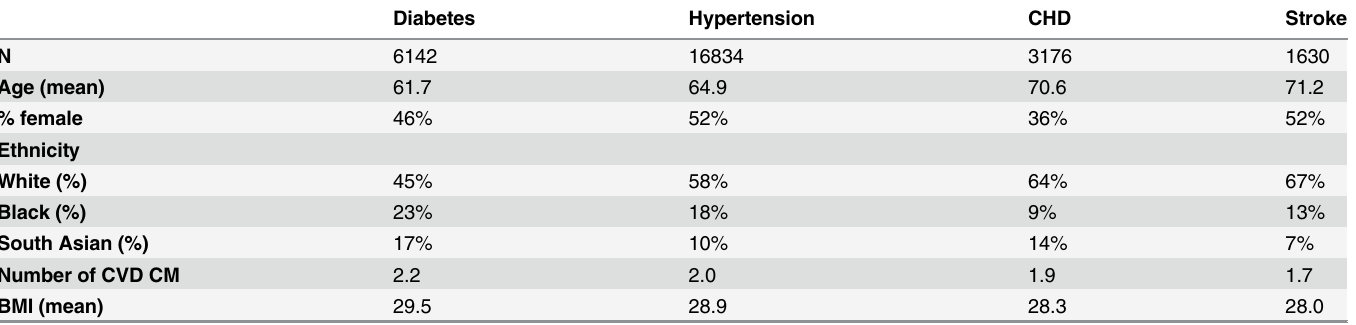
Table 2. Number of patients per disease groups and their average age, proportion of females, ethnicity, number of cardiovascular disease co-mor- bidities and body-mass-index for